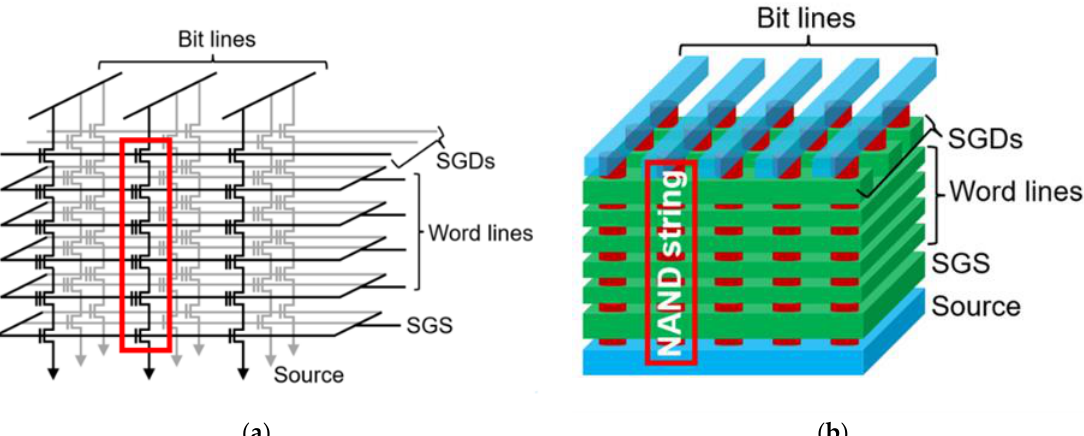
Figure 2. 3D NAND array architecture [35]. ( a ) Schematics of 3 × 3 NAND strings and ( b ) bird’s eye view of 3 × 5 NAND strings. Only 4 word lines (WLs) in a string are shown for visibility. The actual 3D NAND has more than 128 WLs in a string.